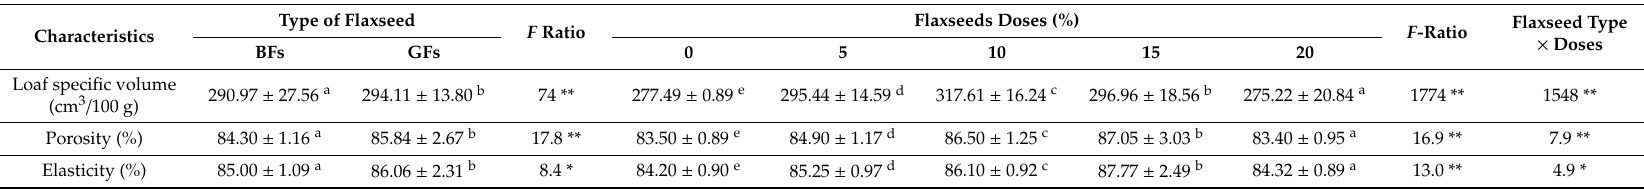
Table 5. Analysis of variance of the influence of flaxseeds from the brown variety (BFs) and golden variety (GFs) addition on physical characteristics of bread obtained from strong quality flour for bread-making.